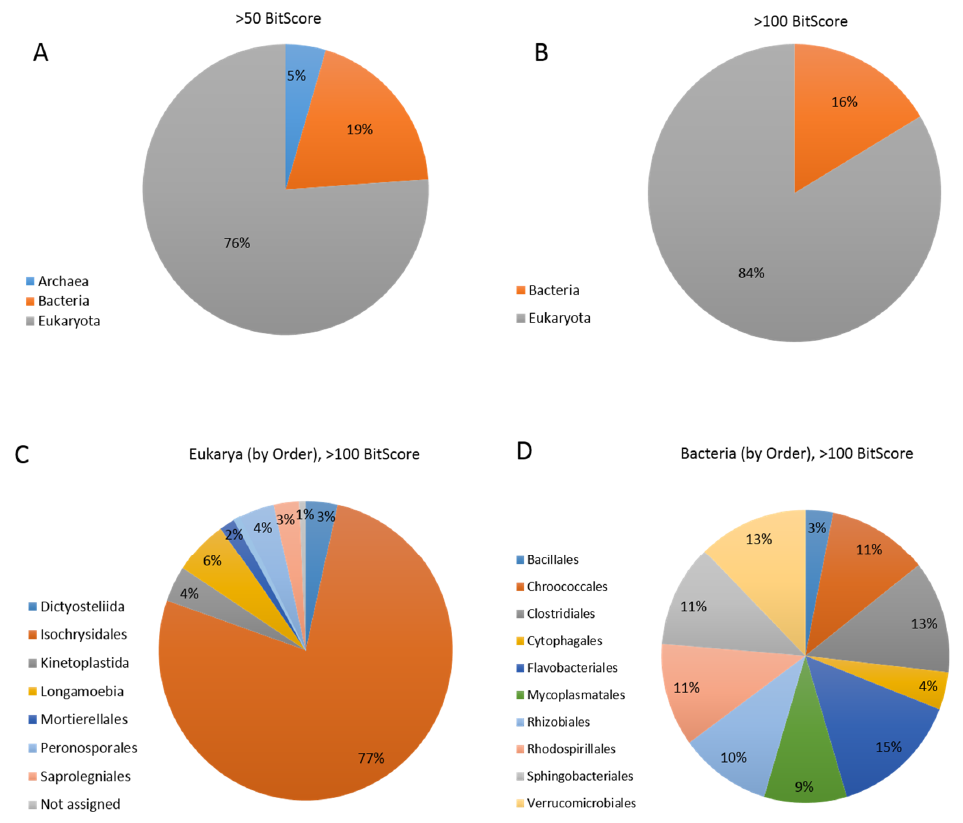
Figure 3. “Best BLAST hit” analysis of coccolithovirus CDSs in relation to the three domains of life: Eukarya, Bacteria and Archaea. Predicted genes within EhV genomes were BLASTp analyzed against possible hits in the three domains of life using a gene BitScore of >50 ( A ); and >100 ( B ). Further EhV gene hits analysis to the taxonomic level of “order” in Eukarya ( C ); and Bacteria ( D ) was performed using a BitScore of >100.